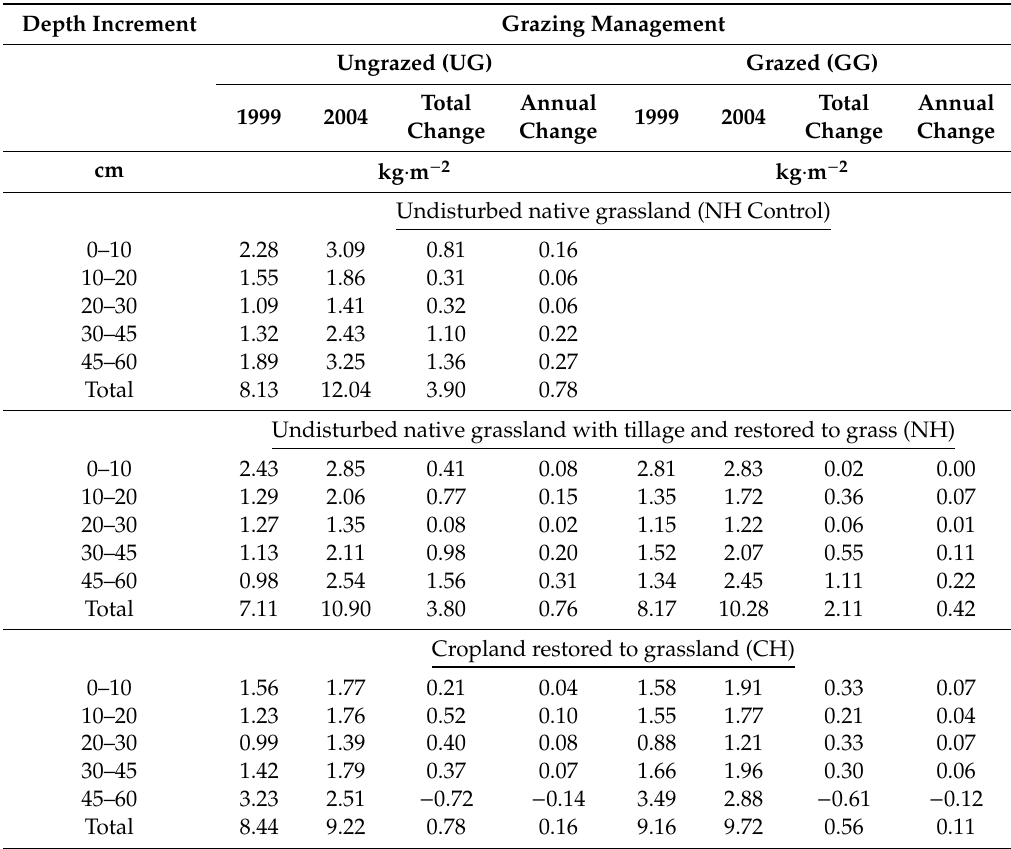
Table 4. E ff ects of management on profile changes in soil total carbon levels over a five year period for undisturbed native grassland that was tilled and restored to grassland and cropland converted to grass. Depth Increment Grazing Management Ungrazed (UG) Grazed (GG) Total Annual Total Annual 1999 2004 1999 2004 Change Change Change